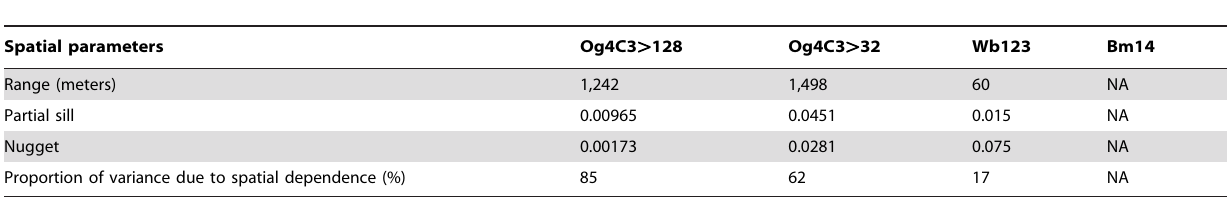
Table 2. Spatial parameters of geographical clustering of Og4C3 antigen, and Wb123 and Bm14 antibodies.